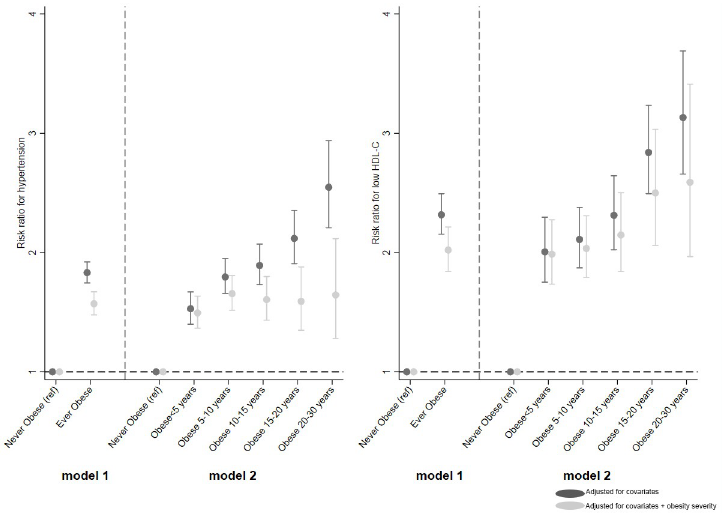
Fig 4. Association between ever obese and categories of obesity duration (versus never obese) and risk for hypertension and low HDL-C.